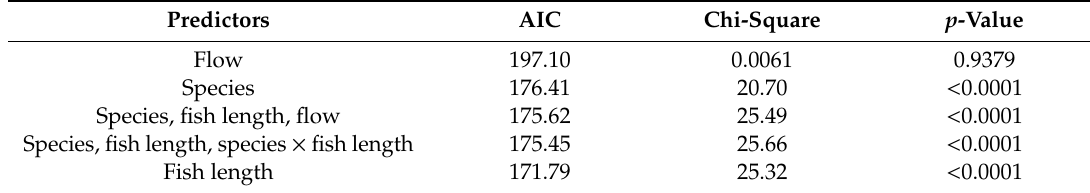
Table 2. Summary of the results for di ff erent binomial generalized linear models (GLMs) carried